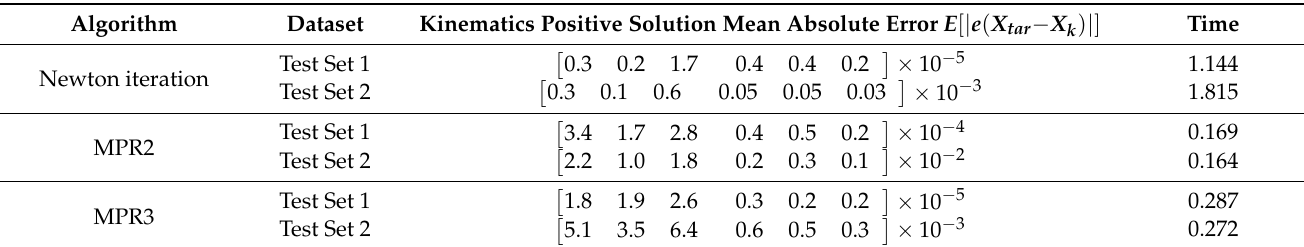
Table 2. Comparison of Newton iteration method and polynomial regression